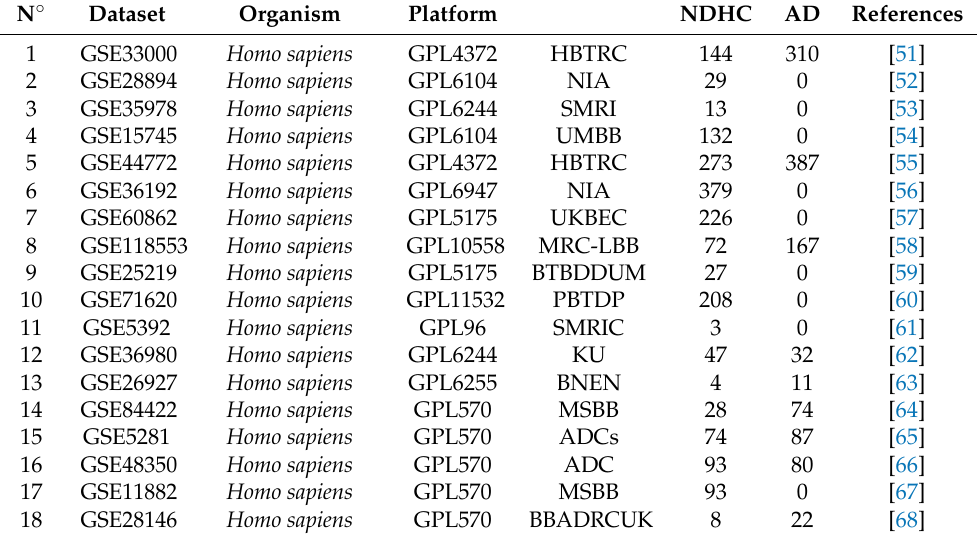
Table 1. Datasets selected.